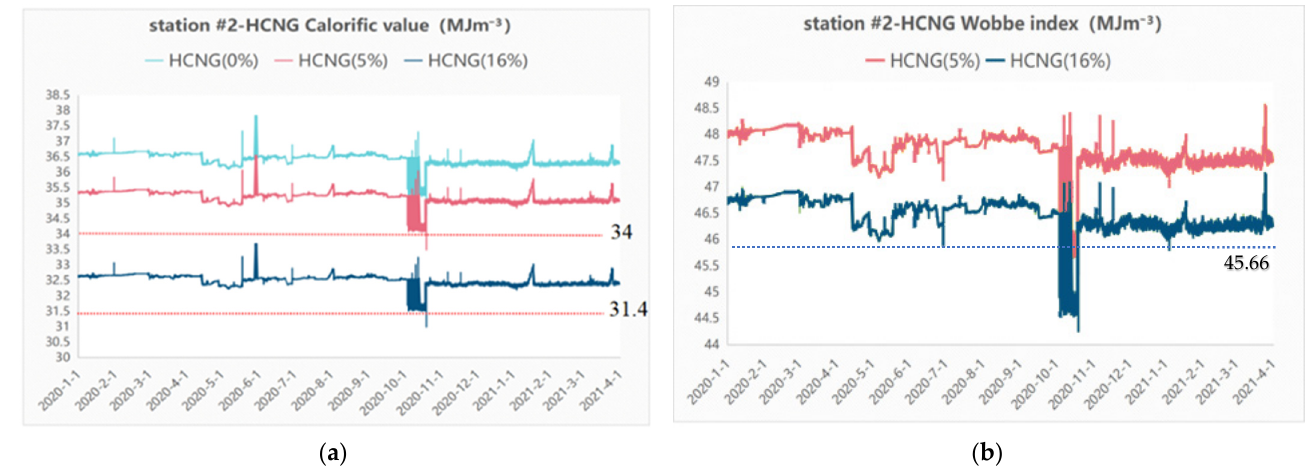
Figure 4. ( a ) Calorific value of natural gas source station #2 measured between 2020.1 and 2020.4 . ( b ) Wobbe Index of natural gas source station #2 measured between 2020.1 and 2020.4.